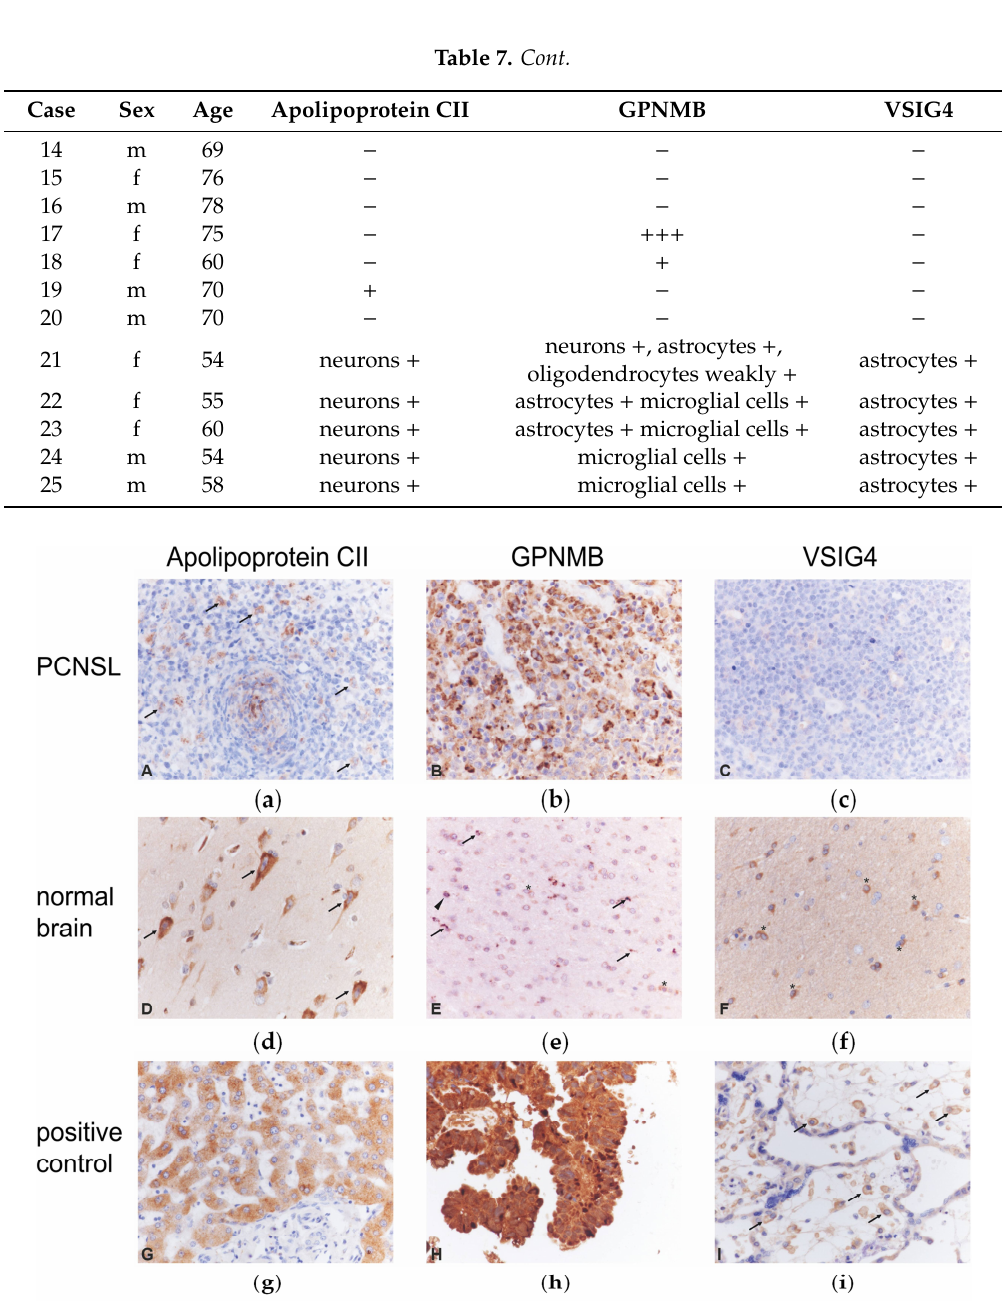
Figure 5. Protein distribution of apolipoprotein CII, GPNMB and VSIG4 in PCNSL and normal brain: ( a ) apolipoprotein CII in PCNSL, ( b ) GPNMB in PCNSL, ( c ) VSIG4 in PCNSL, ( d ) apolipoprotein CII in normal brain, ( e ) GPNMB in normal brain, ( f ) VSIG4 in normal brain, ( g ) apolipoprotein CII in positive control, ( h ) GPNMB in positive control, ( i ) VSIG4 in positive control. In PCNSL, apolipoprotein CII is expressed by a few tumor cells ( a, arrows ) and GPNMB by numerous tumor cells ( b ). The tumor cells do not express VSIG4 ( c ). In the normal brain, cortical neurons show a cytoplasmic expression of apolipoprotein CII ( d, arrows ). Microglial cells (arrows), an oligodendrocyte (arrowhead) and astrocytes (asterisks) express GPNMB ( e ). Astrocytes show a cytoplasmic expression of VSIG4 ( f, asterisks ). Normal hepatic tissue, colon carcinoma, and placenta were used as control tissue for apolipoprotein CII ( g ), GPNMB ( h ), VSIG4 ( i, arrows ), respectively. Immunohistochemistry with polyclonal rabbit anti-apolipoprotein CII (Abcam, Cambridge, UK), rabbit anti-GPNMB (clone E4D7P, Cell Signaling, slight counterstaining with hemalum; original magnification ×